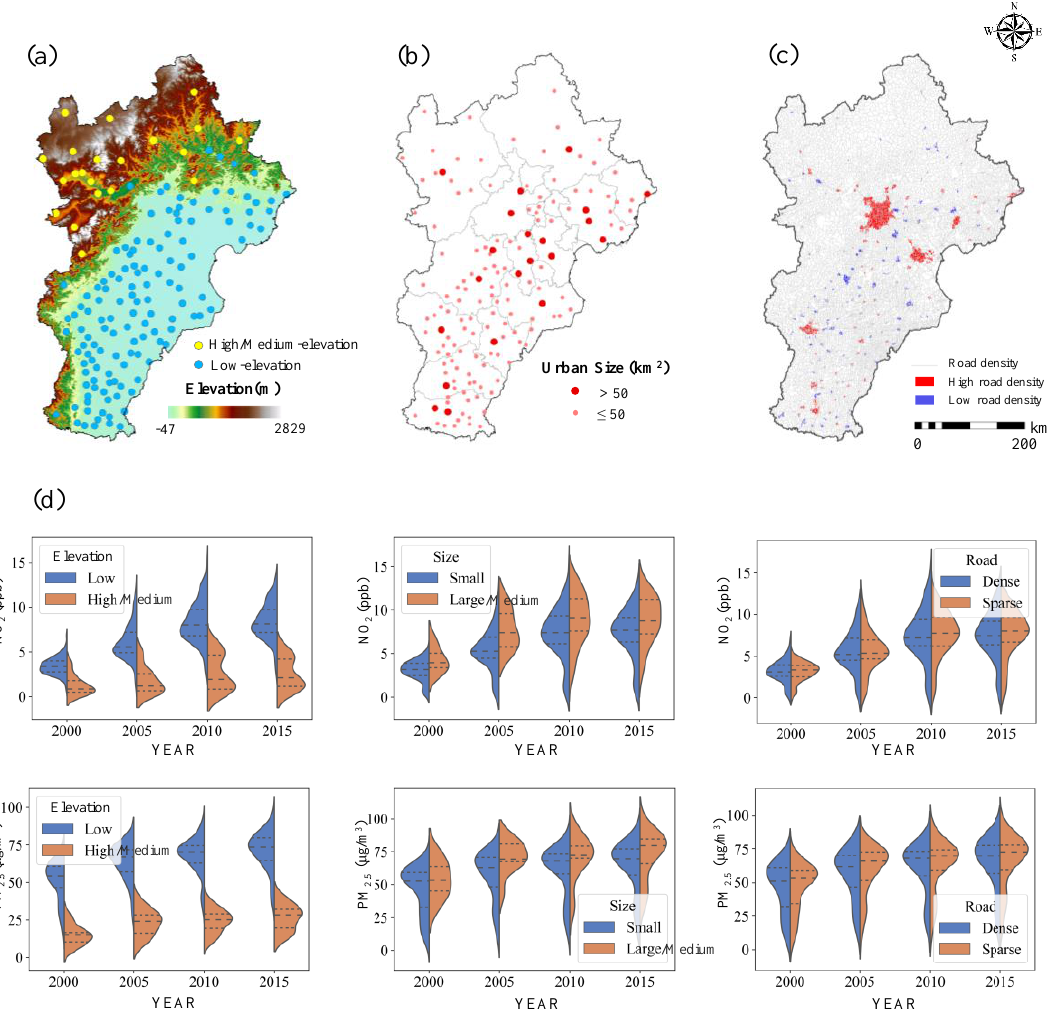
Figure 5. The locations of cities with different elevations ( a ), area scales ( b ), and road network densities ( c ) and their respective statistical distribution of air pollution levels ( d ).